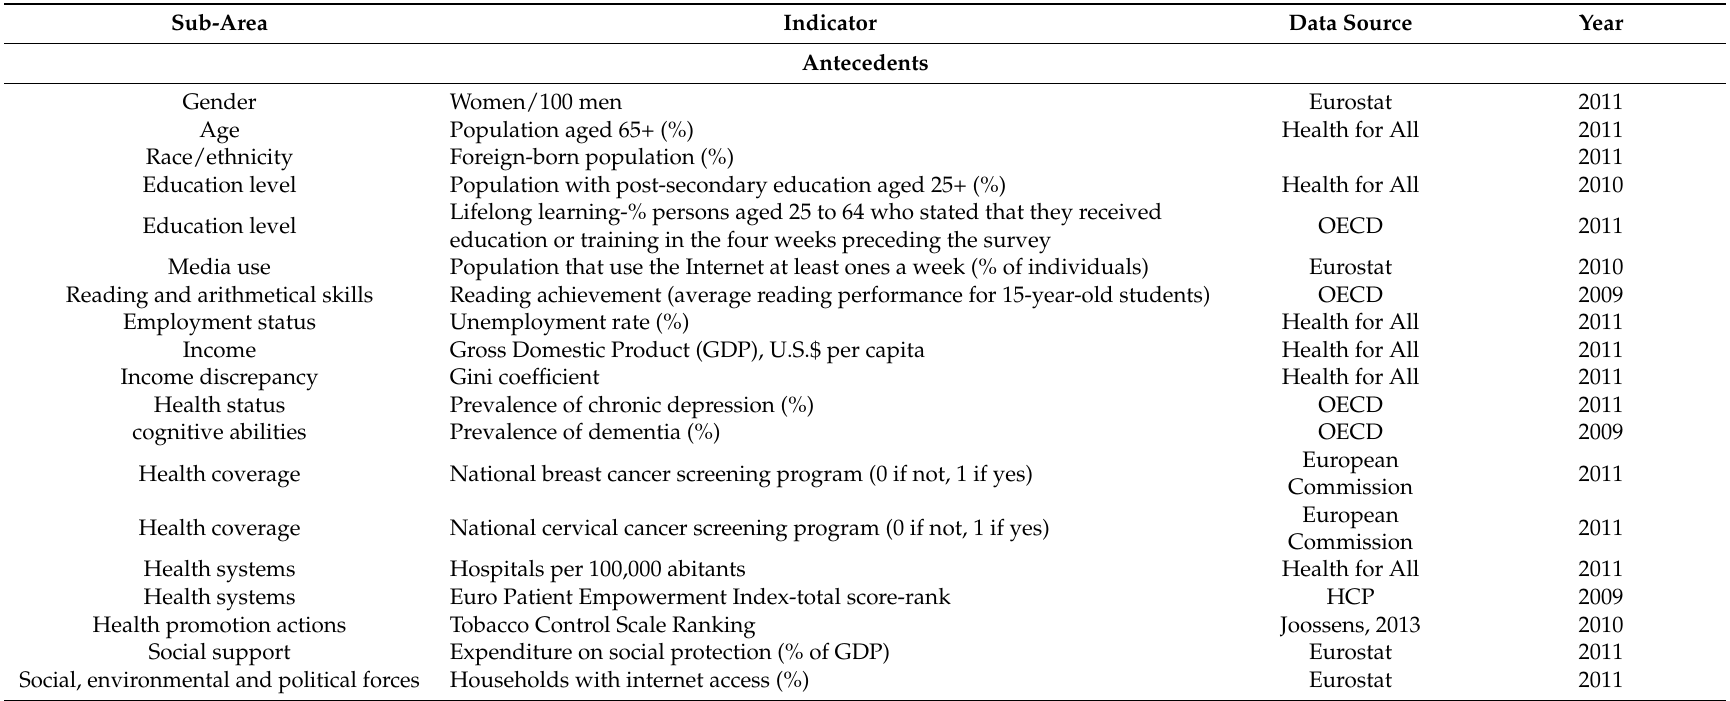
Table 3. Indicators included in the correlation analysis and data